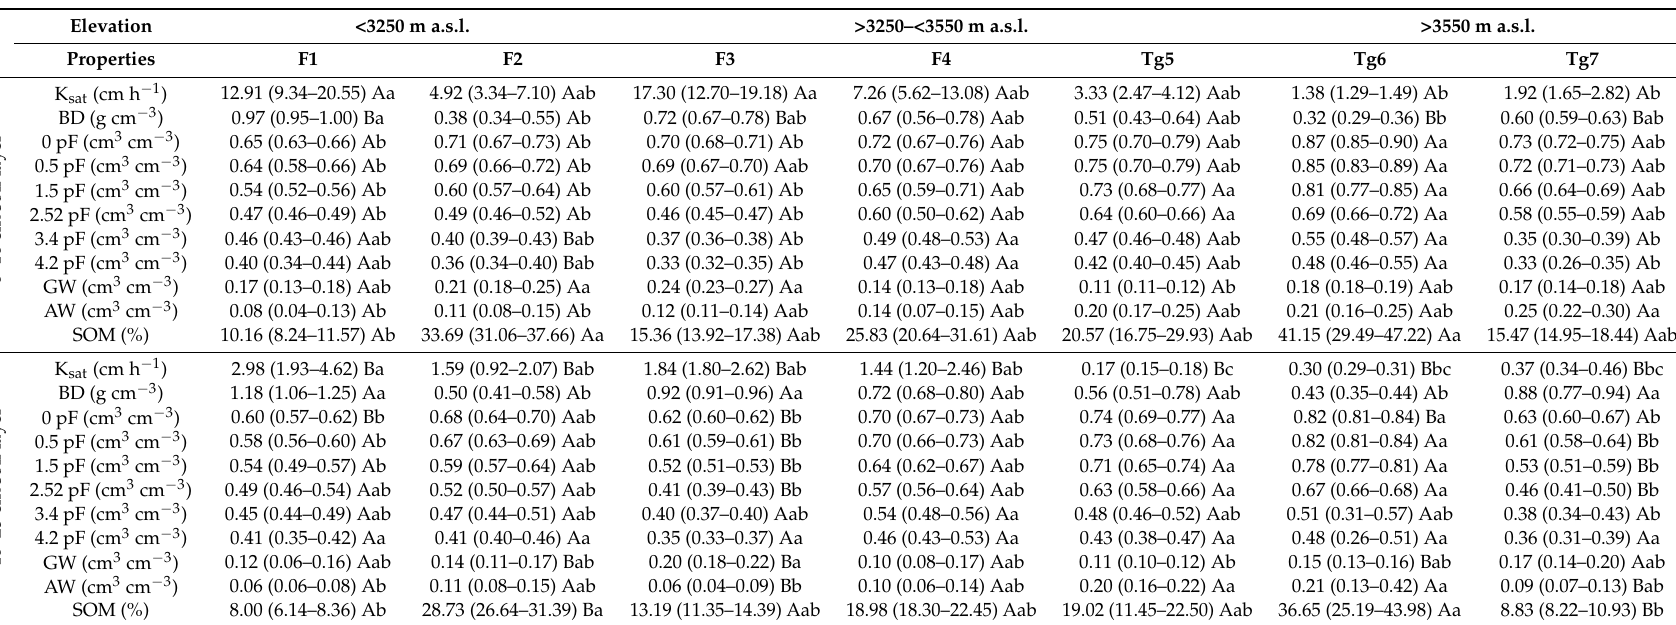
Table A1. Median and the 25th and 75th percentile of the hydro-physical properties and SOM content of the soil in the undisturbed natural cover areas (Azuay province, southern